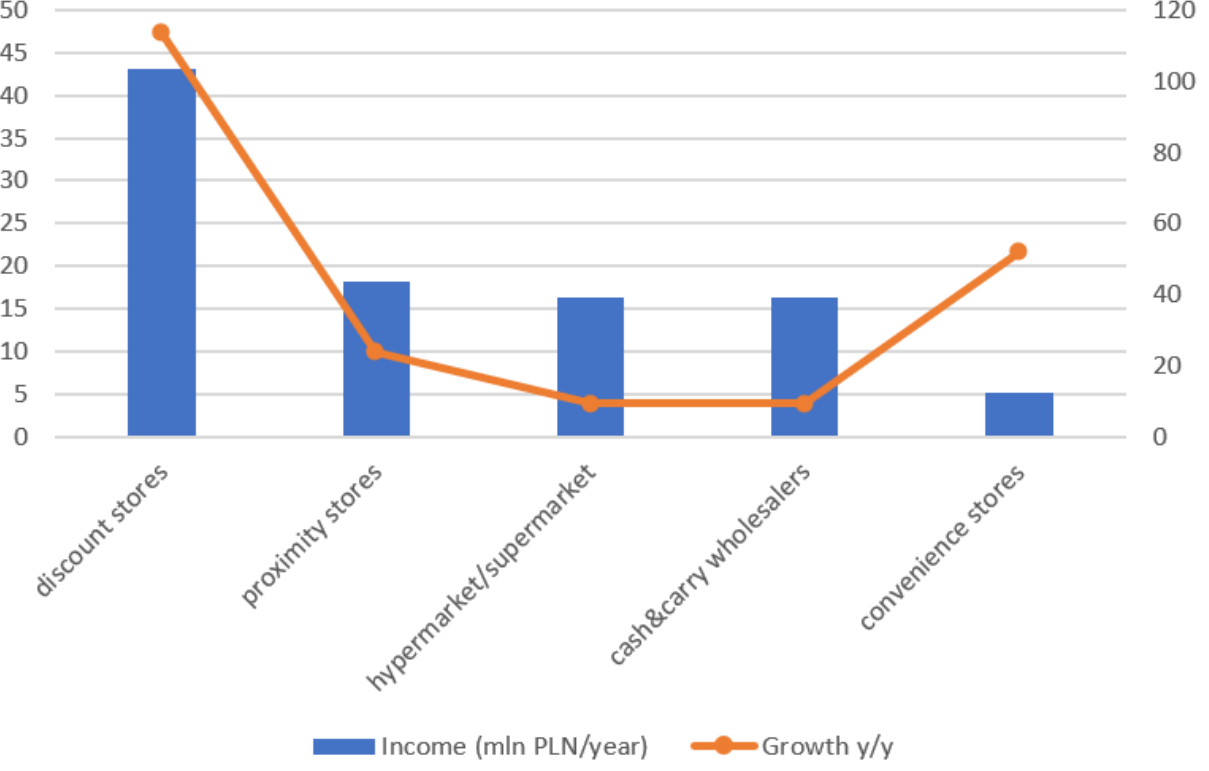
Figure 1. Revenue of various retail locations for 2020 [22].